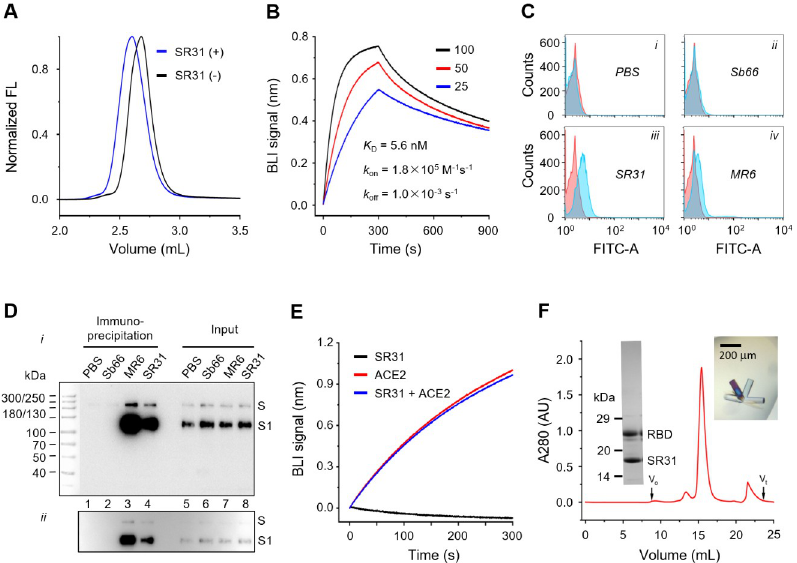
Fig 1. SR31 binds RBD with high affinity but does not perturb ACE2 binding. ( A ) FSEC of RBD in the absence (black) and presence (blue) of SR31. ( B ) Bio-layer interferometry (BLI) assay with RBD immobilized and SR31 as analyte at three concentrations (nM). ( C ) Analytic fluorescence-activated cell sorting (FACS) of HEK293T cells expressing the full-length S without staining (red), or with staining in the presence of PBS ( i ) or indicated sybodies ( ii- iv ) (cyan). ( D ) Pull-down of S expressed on the surface of SARS-CoV-2 pseudoviruses using His-tagged sybodies immobilized on Ni-NTA resin. Lanes 1–4 show the elution and lanes 5–8 show the input. Immunoblot bands of the full-length S and the S1 subunit were detected using anti-S1 antibody and conjugated secondary antibodies. Characteristically [4], the full-length S of SARS-CoV-2 is mostly processed. Images of the blot with different exposure are shown ( i , ii ). The bright-field image of the prestained molecular marker was merged with the chemiluminescent image of the immunoblots. ( E ) SR31 does not inhibit ACE2 binding. An RBD-coated sensor saturated with SR31 was soaked in 50 nM of SR31 with (blue) and without (black) 25 nM ACE2. As a control, the assay was performed with RBD immobilized and ACE2 as analyte (red). ( F ) Purification (SEC and SDS-PAGE) and crystallization of the RBD-SR31 complex. Void volume (V o ) and total volume (V t ) are appropriately